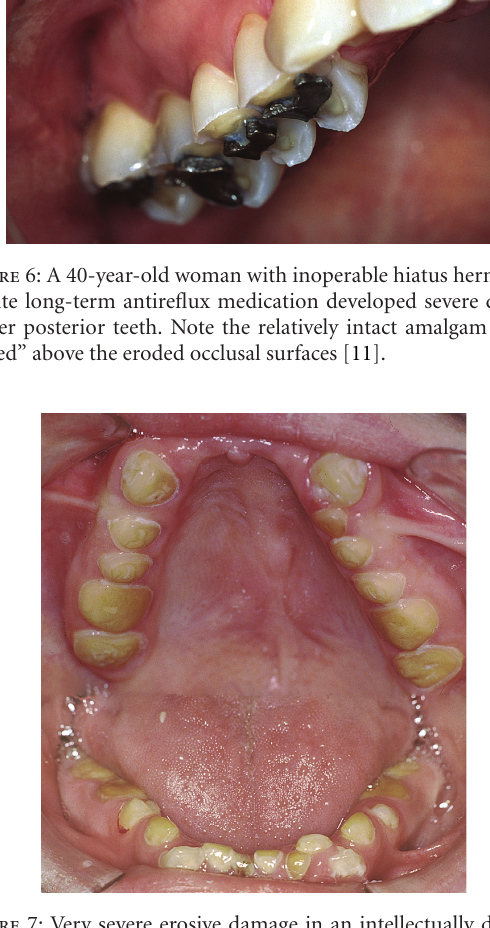
Figure 7: Very severe erosive damage in an intellectually disabled 17-year-old boy with a habit of frequent rumination. In addition to rumination he also su ff ers from GERD